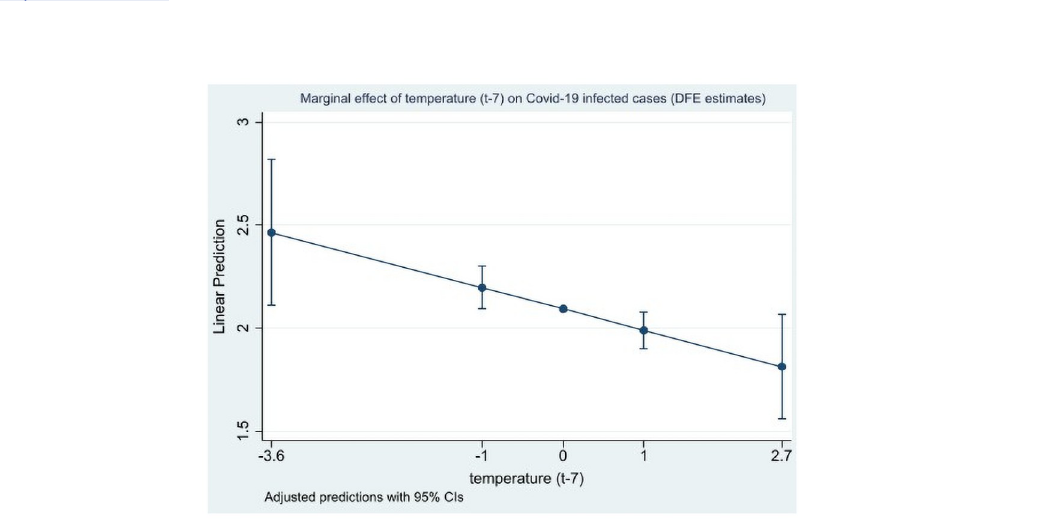
Fig 1. Marginal effects of temperature (t-7) on Covid-19 infected cases (direct effect with DFE estimates). Marginal effects are computed at the min, -1 std. deviation, mean, + 1 std. deviation, and max values of the (standardized) temperature